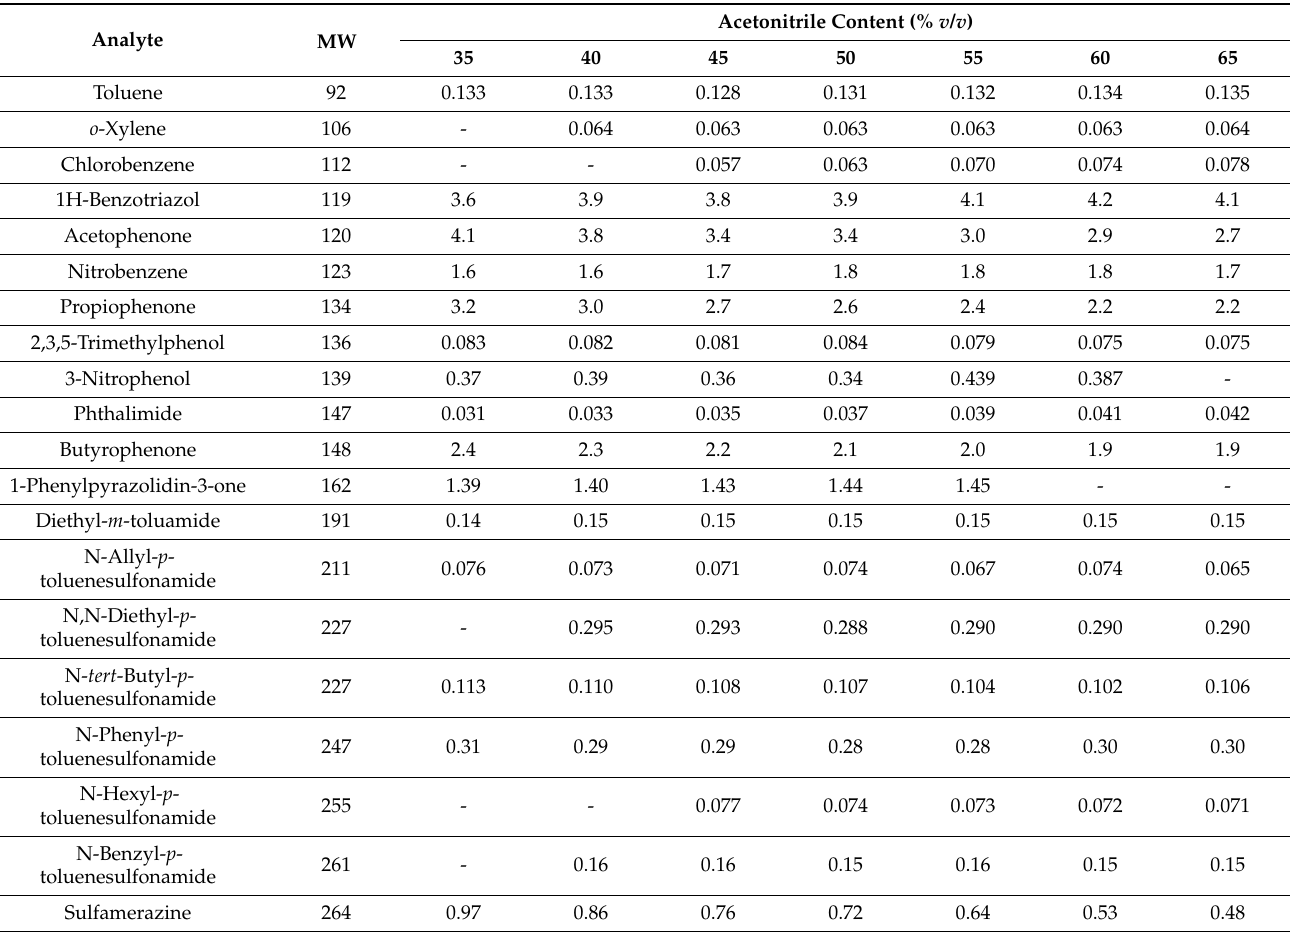
Table 5. Relative optical densities A (254)/ A (220) of some organic compounds, depending on the acetonitrile content in the